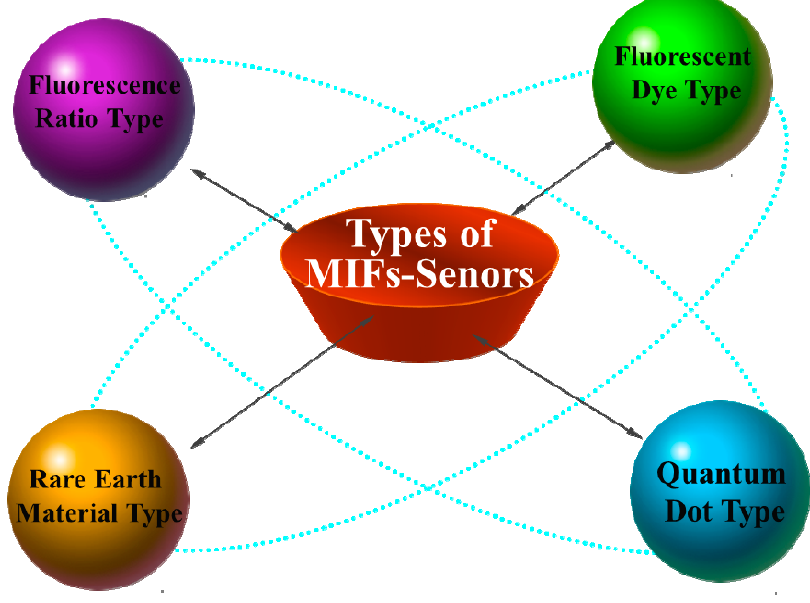
Figure 3. Four types of MIFs based on different fluorescence signals sources.